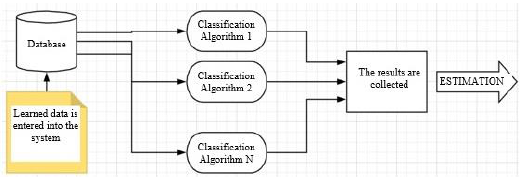
Figure 4. Ensemble Classification Working Mechanism